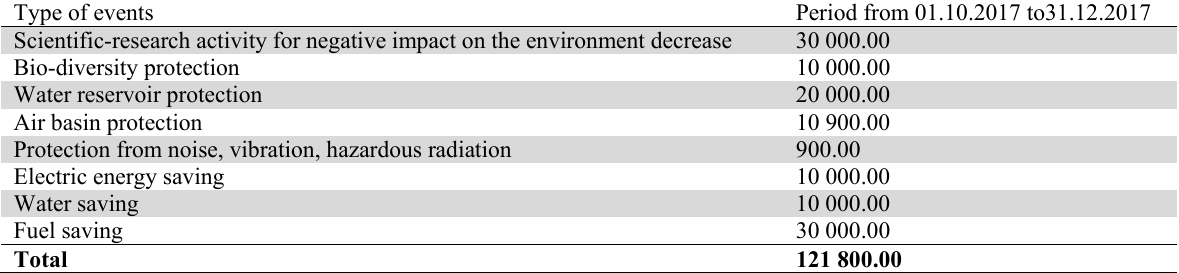
Nonfinancial accounting form “Report: Costs for nature protection events implementation” Type of events Period from 01.10.2017